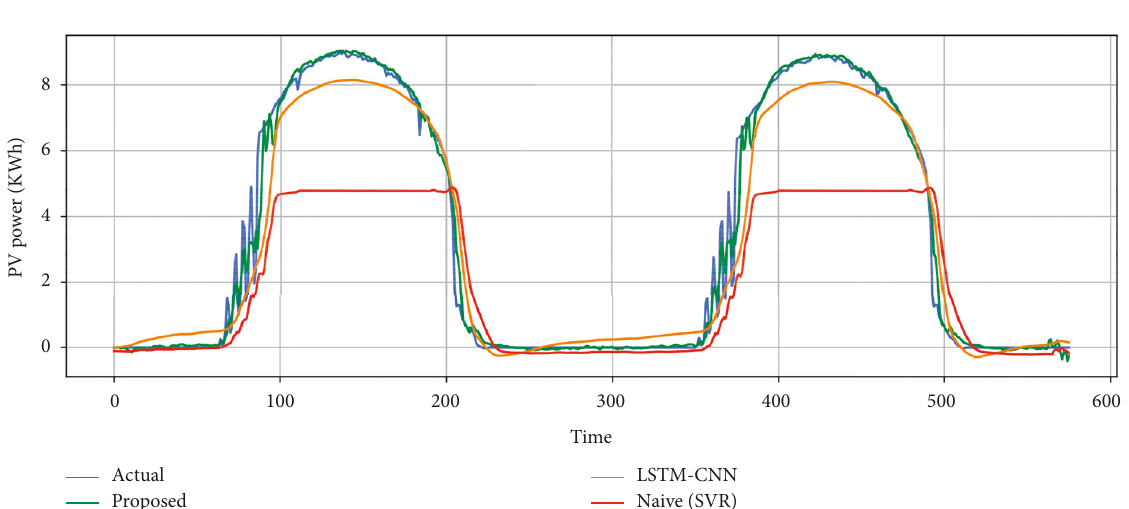
Figure 3: Visual representation to check the predictability of the proposed model with na¨ıve and state-of-the-art model on two days ahead